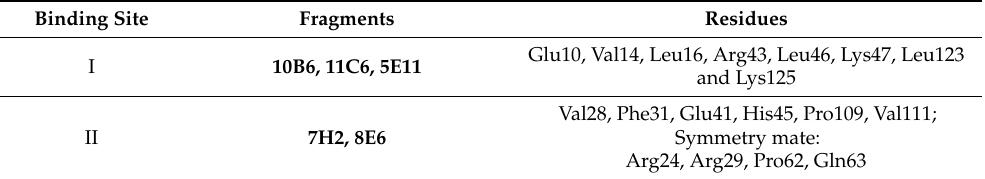
Table 2. List of SARS-CoV-2 nsp1 10-126 amino acids defining binding sites I and